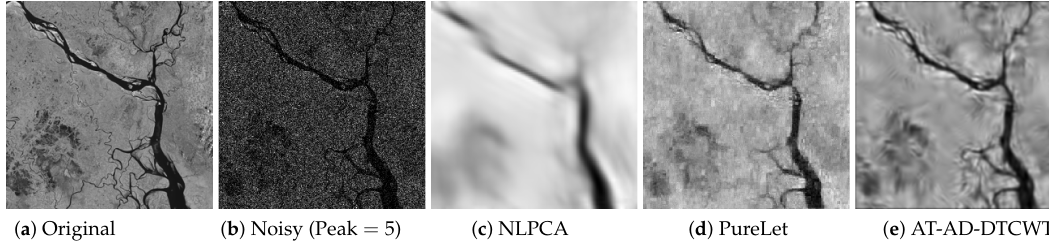
Figure 8. Poisson denoising results on the ‘Lena’ image by various methods at signal peak = 20.